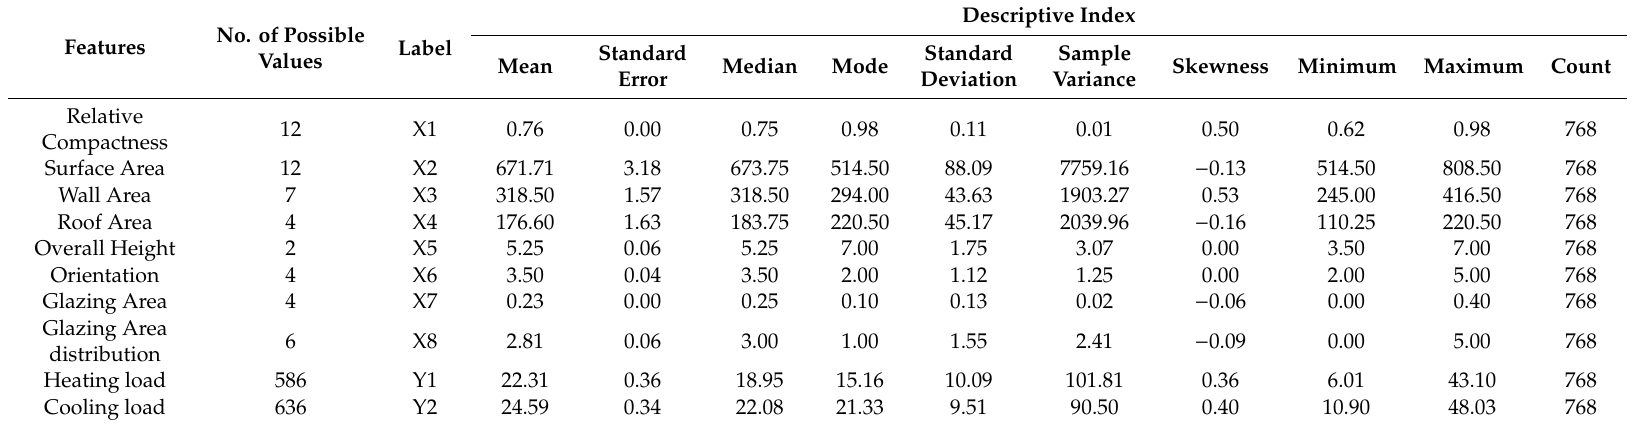
Table 1. Statistical analysis of energy-e ffi cient design on ten features of the e ffi cient